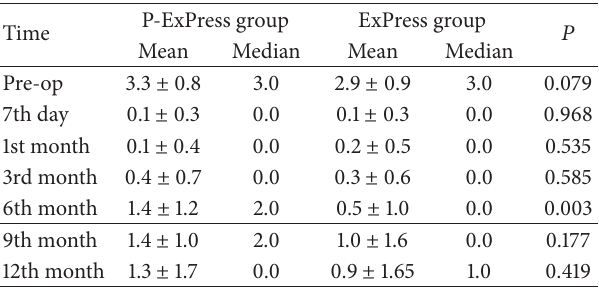
Table3:Amountofhypotensivedrugs:meanvalues,medianvalues, standard deviations, and range in the phaco-ExPress (P-ExPress) and ExPress alone (ExPress) groups at specific times after